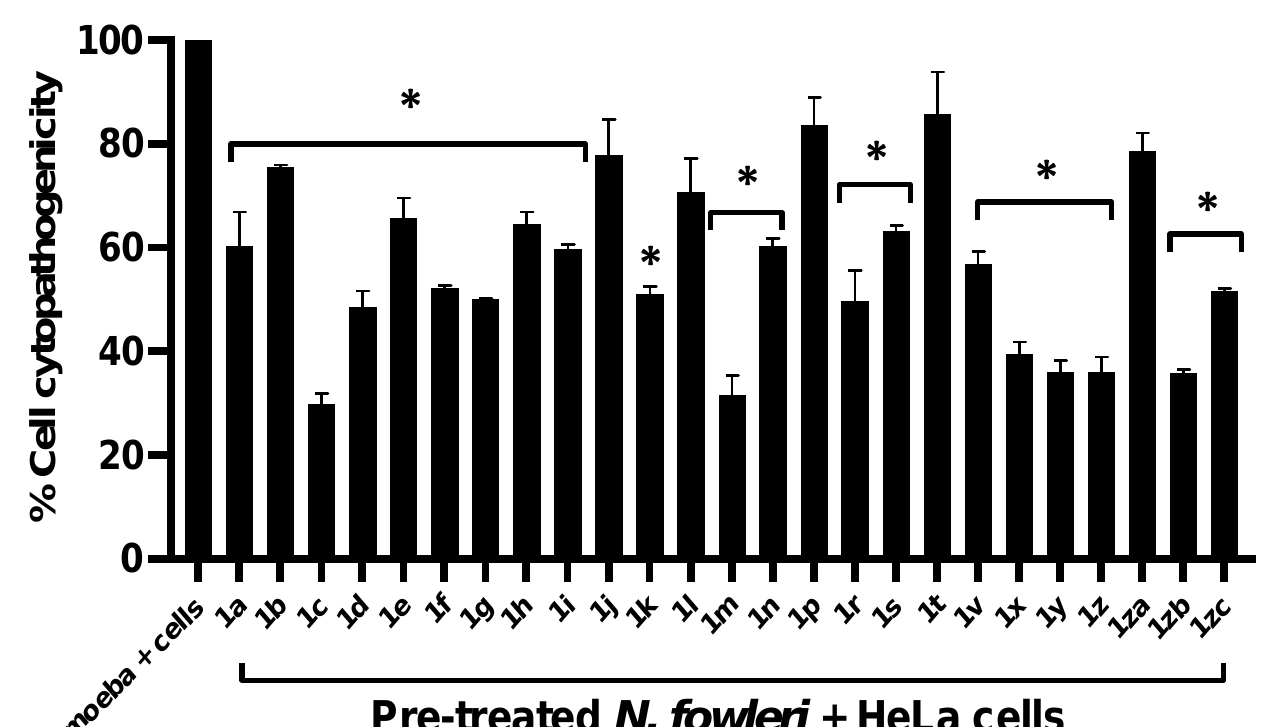
Figure 3. The majority of compounds resulted in decrease in amoeba-mediated cytotoxic activity against human cells. Here, 50 µM of the compounds reduced the Naegleria fowleri- mediated cytotoxicity against human cells; 2 × 10 5 N. fowleri cells were incubated with 50 µM of the compound for 2 h. Following the incubation period, the pre-treated were amoebae placed on HeLa cell monolayers and incubated overnight. It was found that some of the compounds were capable of inhibiting the amoeba-meditated host cytotoxicity.* Significant reduction in amoeba-mediated cytotoxicity compared to the untreated amoeba + cells.